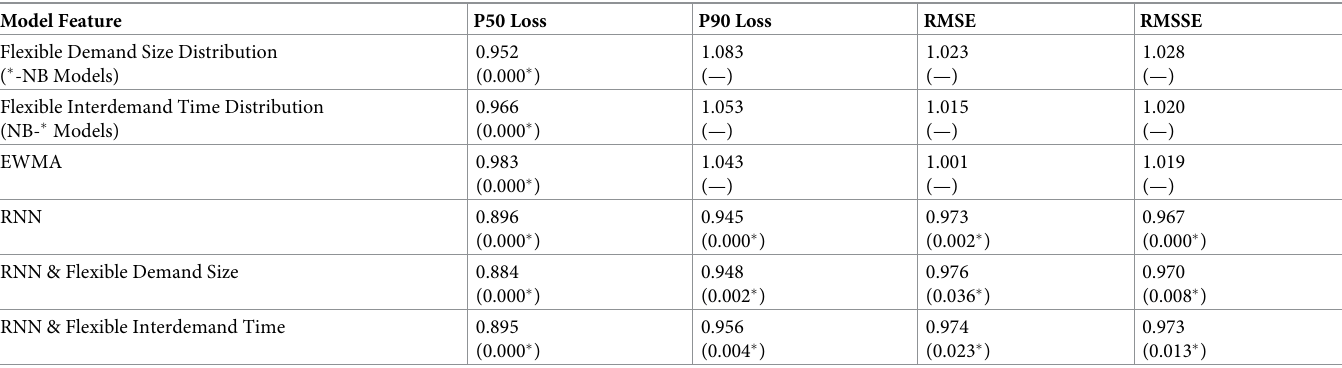
Table 8. Ratios of model families to the Static G-Po baseline model.